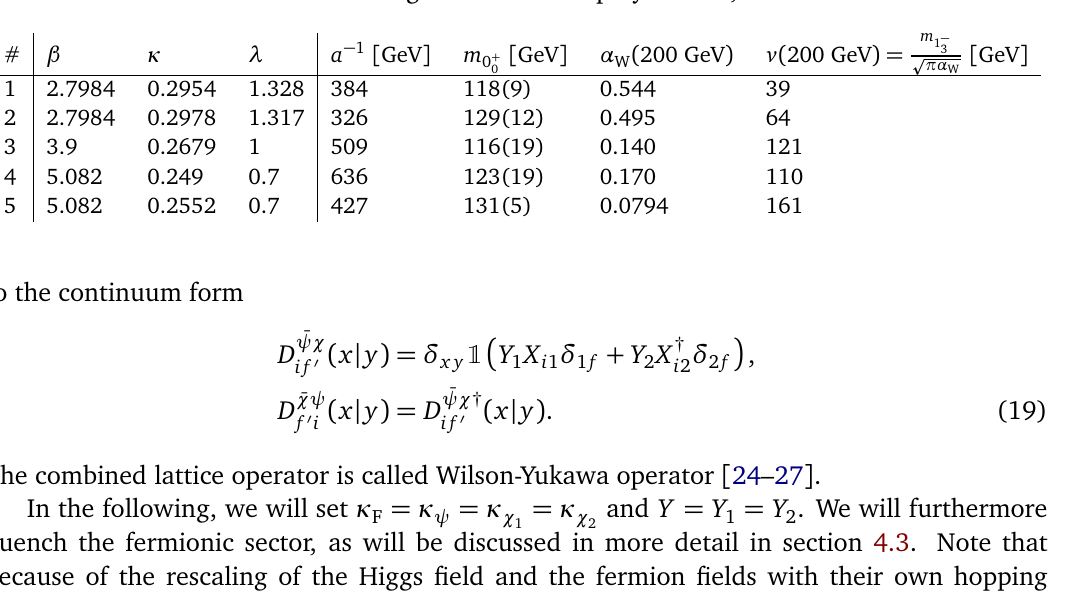
Table 2: Parameters of the quenched configurations as well as their physical char- acterization. Quantities without explicit uncertainties have a statistical error below 1%. The scale was set by fixing the mass of the physical W / Z boson, the custodial = 80.375 GeV. m is the mass of the scalar bound state tr ( X † X ) vector triplet, to m 1 − 0 + 3 0 corresponding to he Higgs boson of our toy model. The running coupling, and thus the vacuum expectation value, are in the miniMOM scheme [ 8,37 ] evaluated at 200 GeV. The results are from the largest volumes employed here, 24 4